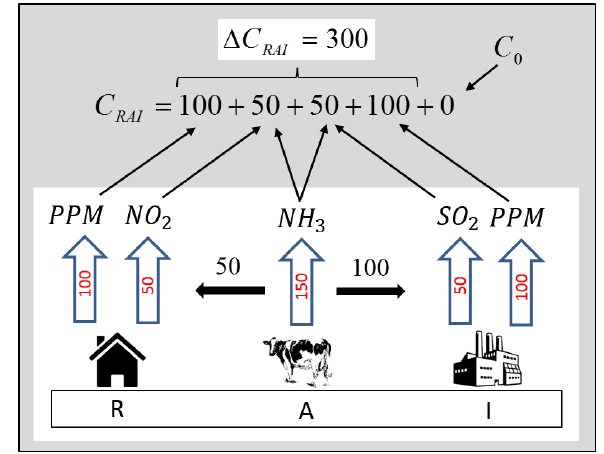
Figure 1. Example of PPM, NO 2 , SO 2 and NH 3 emissions released by three activity sectors: residential (R), agricultural (A) and indus- trial (I). For convenience, no units are associated with emissions and